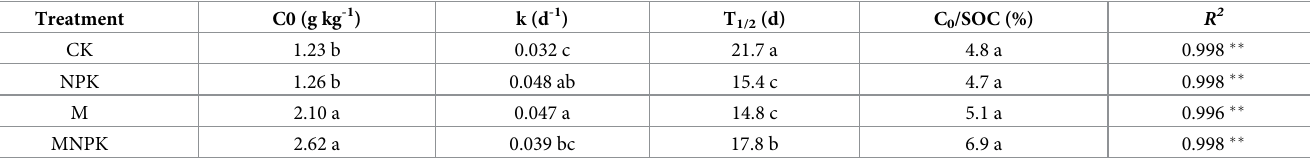
mineralizable carbon in soil, g kg -1 ; k is the turnover rate constant of organic carbon pool, d -1 ; The soil basic physicochemical properties and mineralization parameters were compared using ANOVAs with Microsoft Excel 2010 and SPSS 20.0 software. Multiple comparison post- hoc analyses were performed using the Duncan method to test for significant differences. The bacteria community composition and abundance at the Phylum level for each sample was calculated using R 3.3.2 software. Pearson correlations were used to compare basic soil properties (Table 1) and mineralization parameters (Table 2) in Table 3, and to compare environmental factors and bacterial abundance to generate the correlation matrix heatmap diagram. Principal Component Analysis (PCA) was performed to analyze the bacterial com- munity composition and environmental factors on the Phylum level. This data was analyzed using the free online platform of Majorbio I-Sanger Cloud Platform (www.i-sanger.com). Analysis of Similarities (ANOSIM) was used to determine if differences between groups were greater than intragroup differences. The data were analyzed on the free online platform of Majorbio I-Sanger Cloud Platform (www.i-sanger.com). Table 2. Model parameters and coefficients of determination ( R 2 ) estimated using the first-order exponential model fitted to the cumulative C mineralized data from the different treatments.